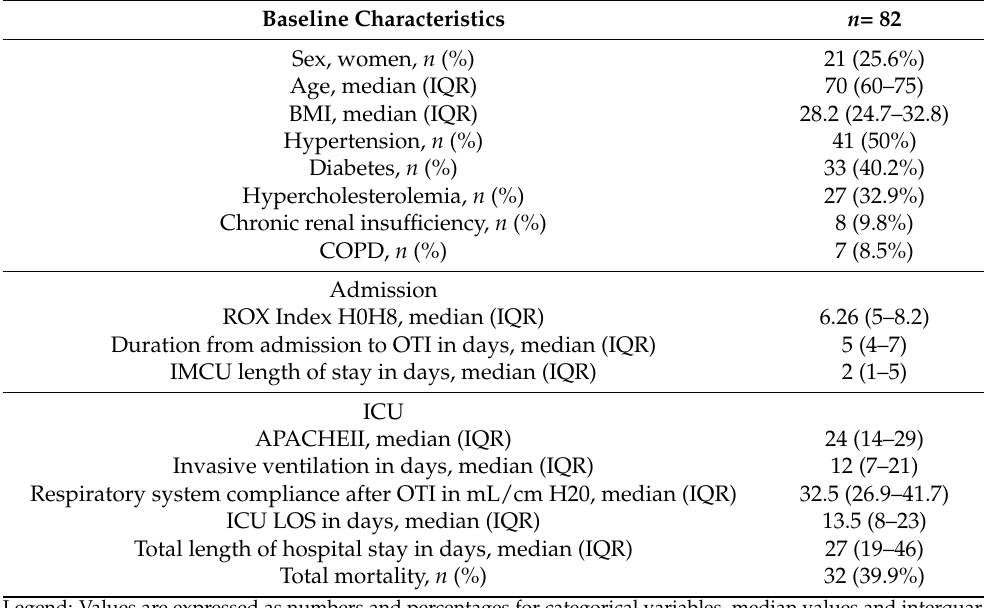
Table 1. Patients’